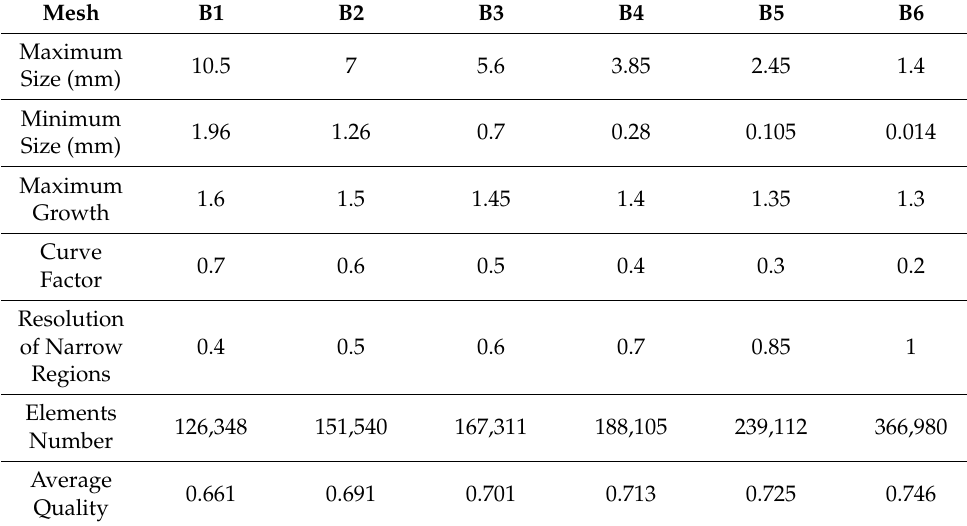
Table 2. Main characteristics of the meshes used for convergence in heat transfer studies.